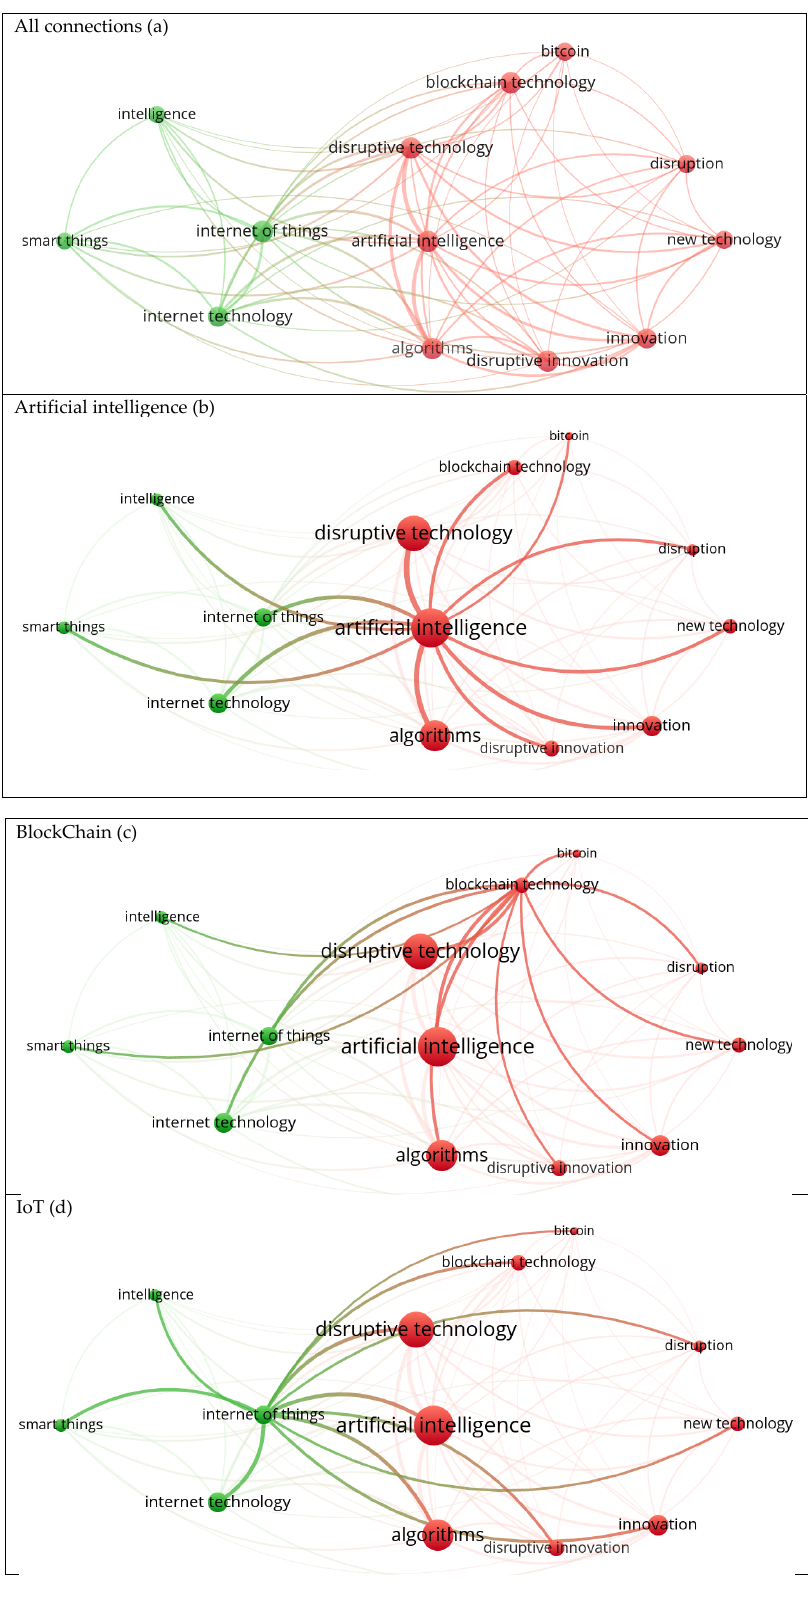
Figure 3. The links ( a – d ) between the top 3 disruptive technologies within the resulting list of papers (n = 97).